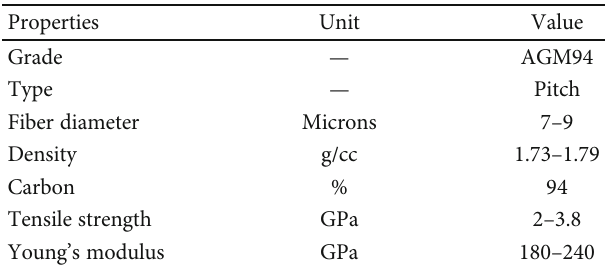
Table 2: Properties of SCF (data from the manufacturer).